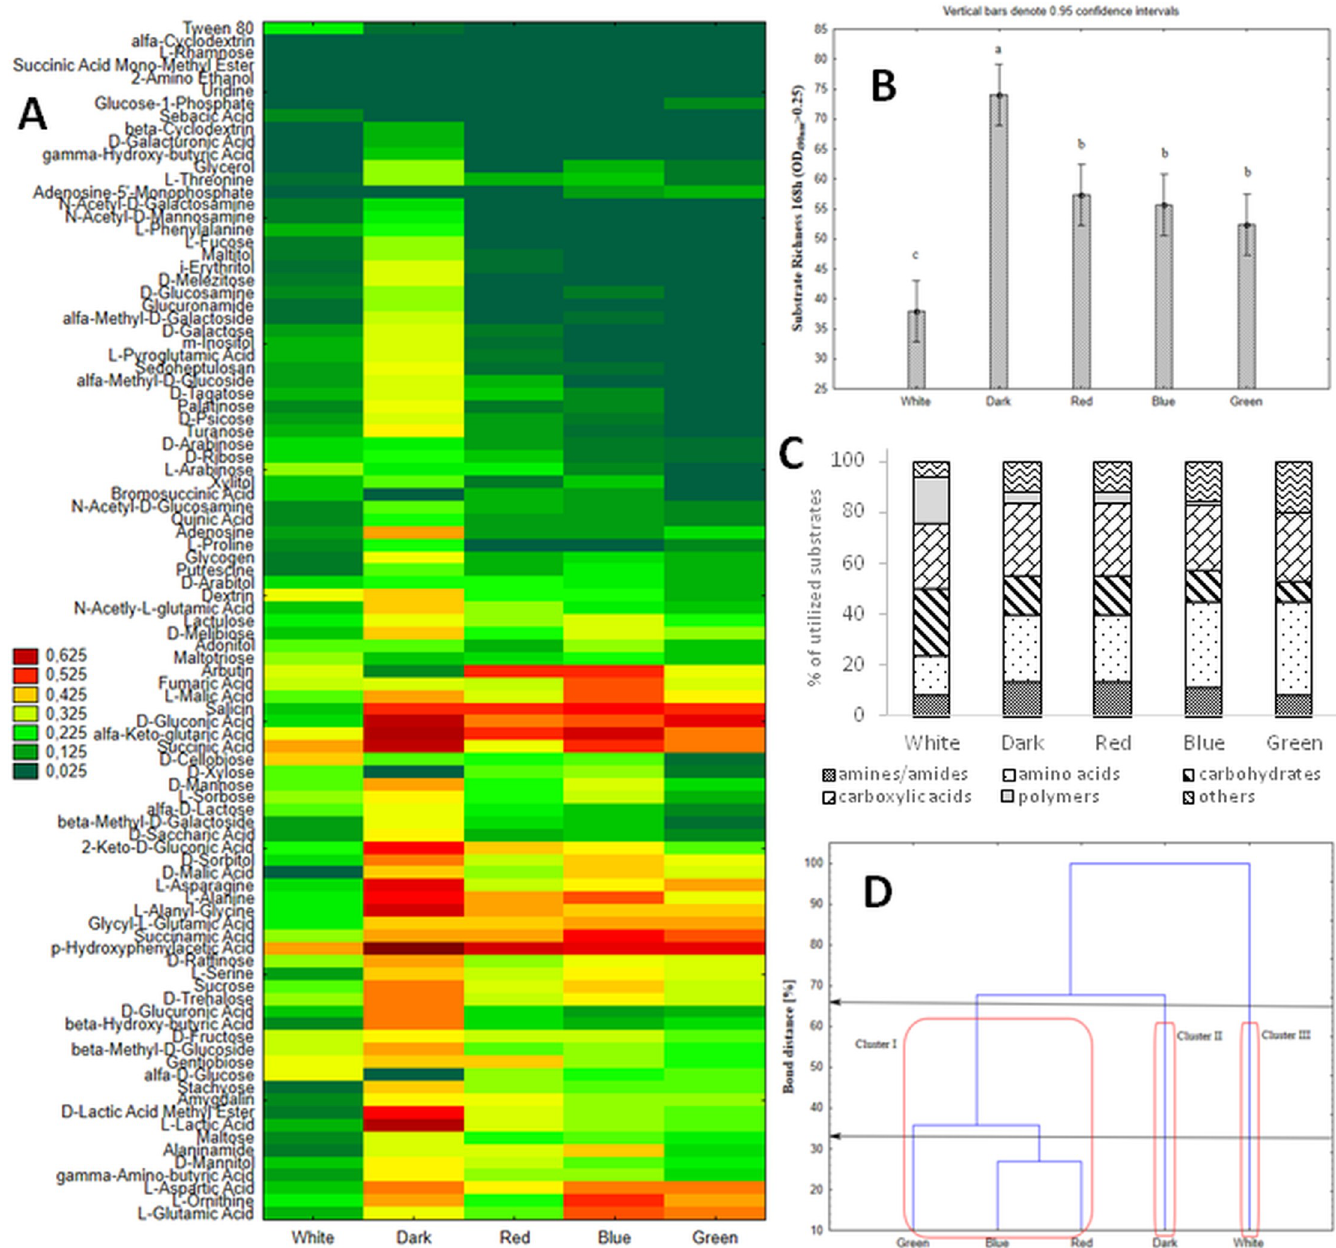
Fig 4. The effect of light on C . unicolor metabolic profiles. (A) FF MP substrate utilization profile of C . unicolor FCL139 cultured in different light conditions (white, red, blue and, green light, darkness) during 168 hours of incubation. The color scale applied into the heat maps indicates the growth of the fungus (mitochondrial activity A 490nm ) on a particular substrate. (B) Substrate richness (R) values of C . unicolor FCL139 cultured in different light conditions (white, red, blue and, green light, darkness); vertical bars denote 0.95 confidence intervals. (C) Metabolic preferences of C . unicolor FCL139 cultured in different light conditions (white, red, blue and, green light, darkness) towards utilization of a particular group of carbon substrates. (D) Cluster analysis-based dendrogram showing similarity of FF MicroPlates C- source utilization profile of C . unicolor FCL139 cultured in different light conditions (white, red, blue and, green light,